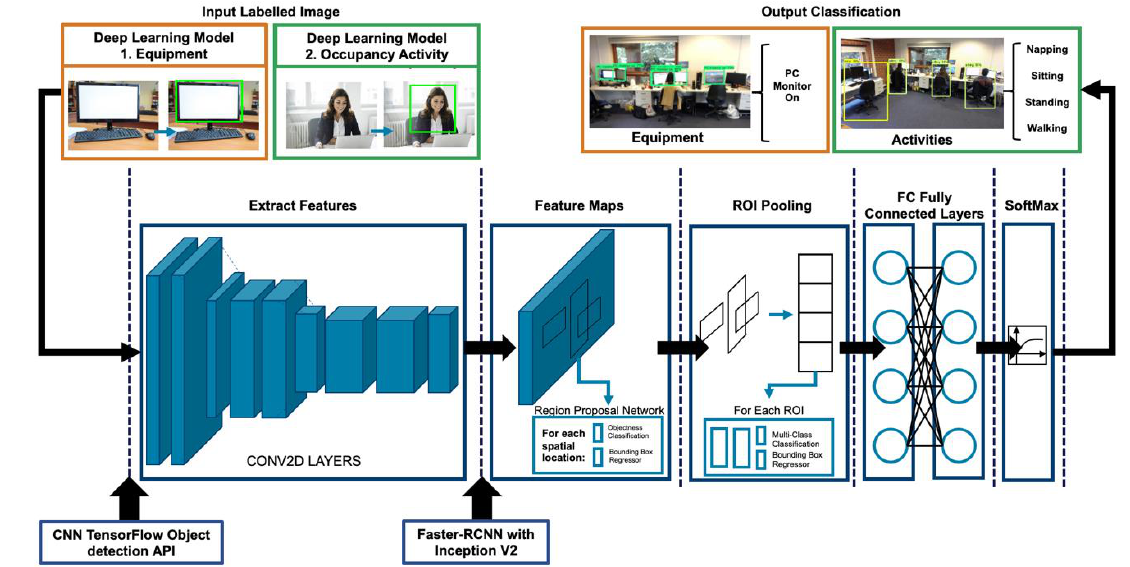
Figure 3. The convolutional neural network (CNN) architecture and configuration used for training the models for detection and recognition.